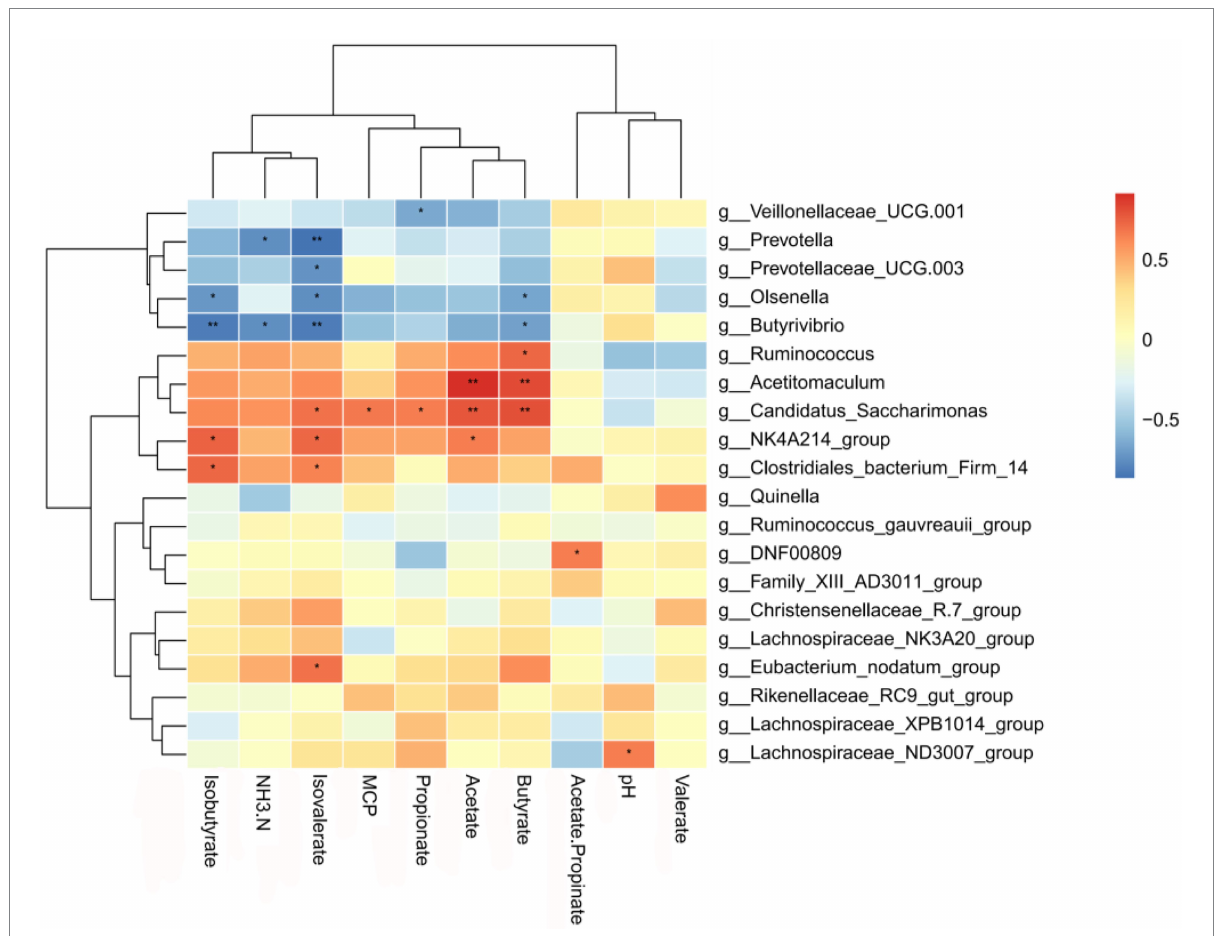
FIGURE 6 Correlation between bacteria and fermentation parameters in the rumen. Each row in the figure represents a genus, each column represents a metabolite, and each grid represents the Pearson correlation coefficient between a component and a metabolite. The red color represents a positive correlation, while the blue color represents a negative correlation. * and ** indicate significant levels of 0.05 and 0.01,